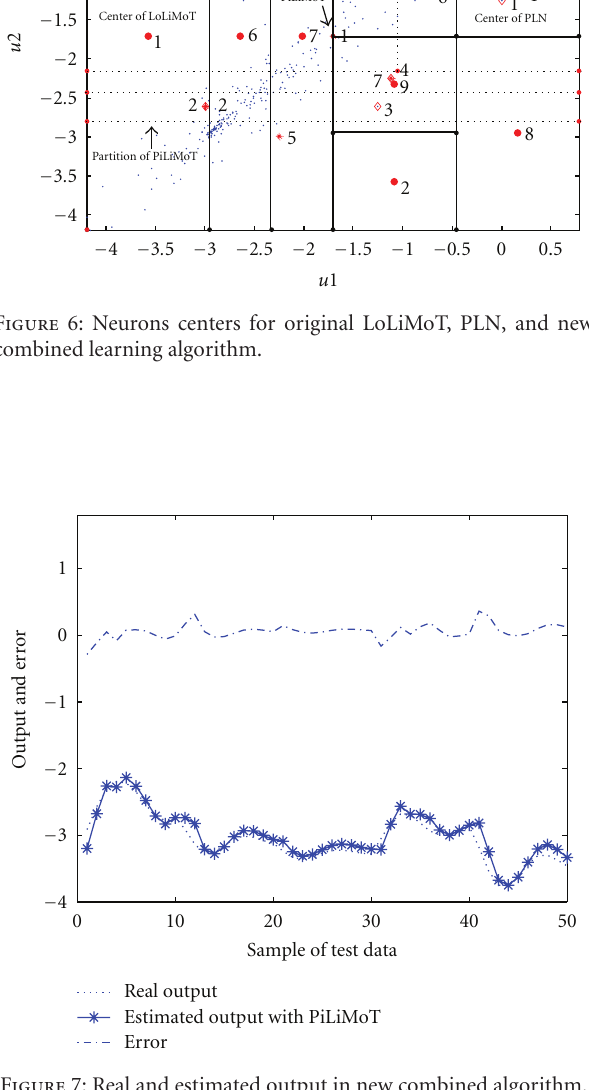
Figure 7: Real and estimated output in new combined